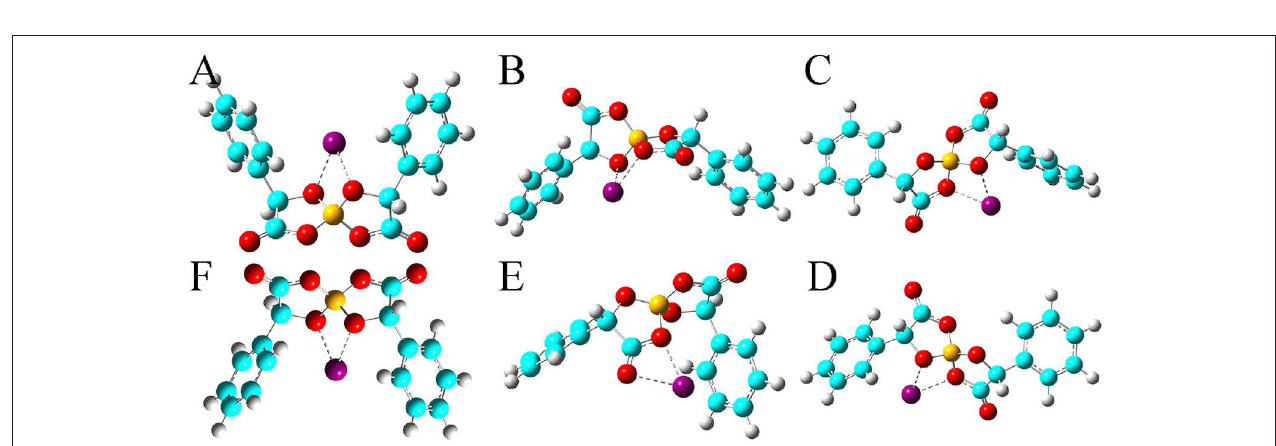
FIGURE 4 | Optimized ion-pair structures of an Na + ion in coordinating [BMB] anions with varied molecular chiralities determined from DFT calculations. The hydrogen, boron, carbon, and oxygen atoms in [BMB] anions are represented by white, yellow, cyan, and red spheres, respectively, and Na + ions are represented by purple spheres. (A) B(R)-Man(RR), (B) B(R)-Man(RS), (C) B(R)-Man(SS), (D) B(S)-Man(RR), (E) B(S)-Man(SR), and (F)